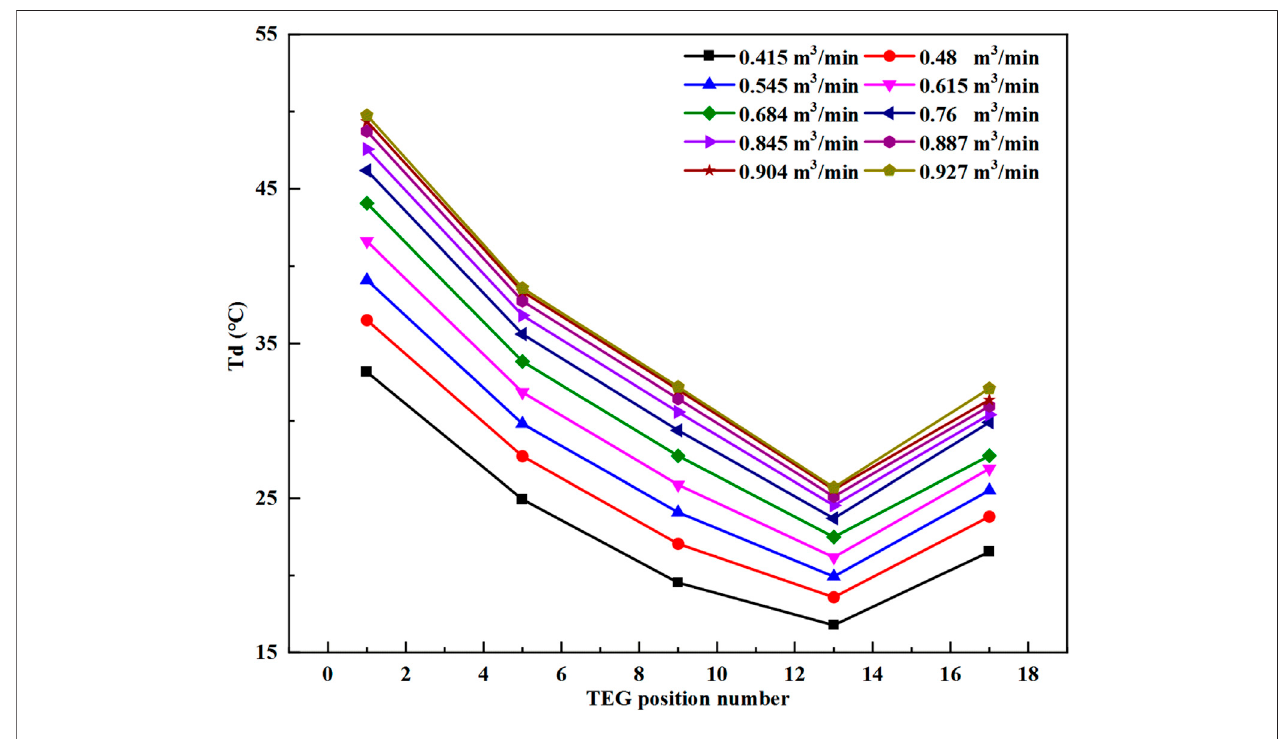
FIGURE 10 | Td curves in different air fl ows.